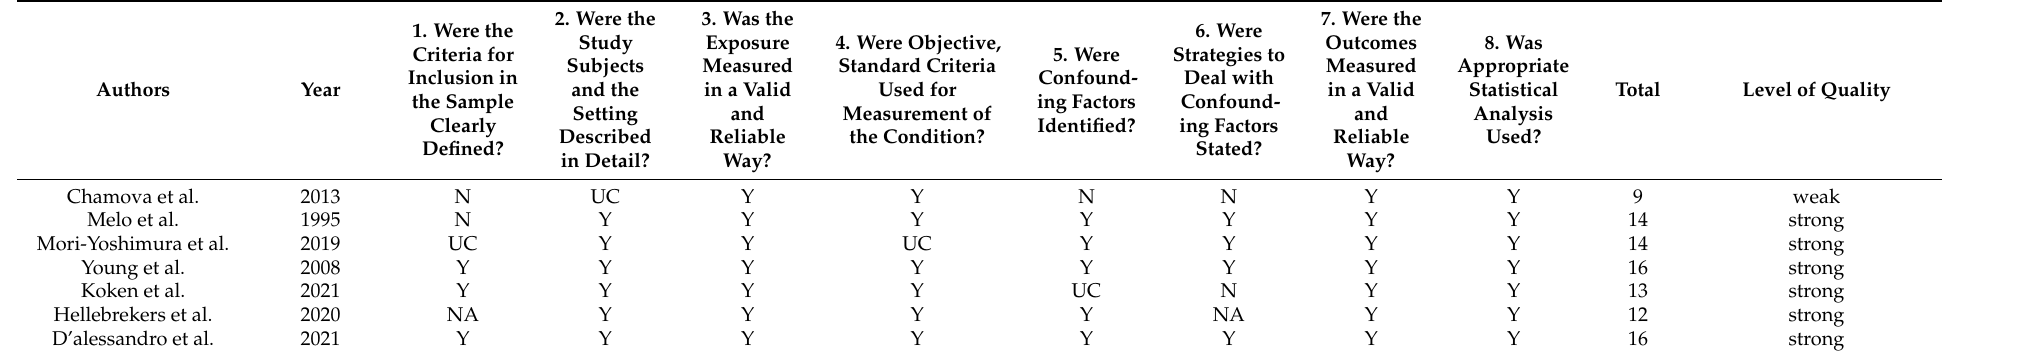
Table A2. Quality of evidence of the BMD